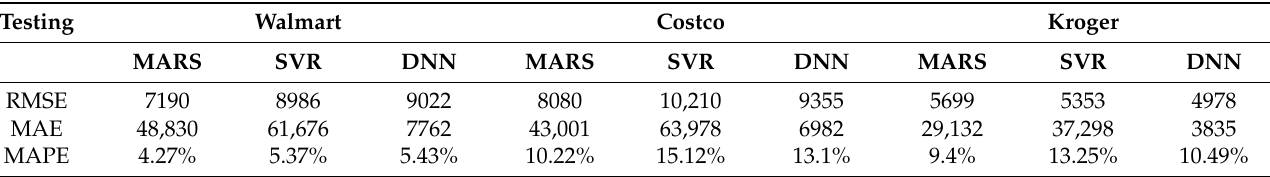
Table 5. Forecasting errors for the testing set (2020/Q1~2021/Q4).